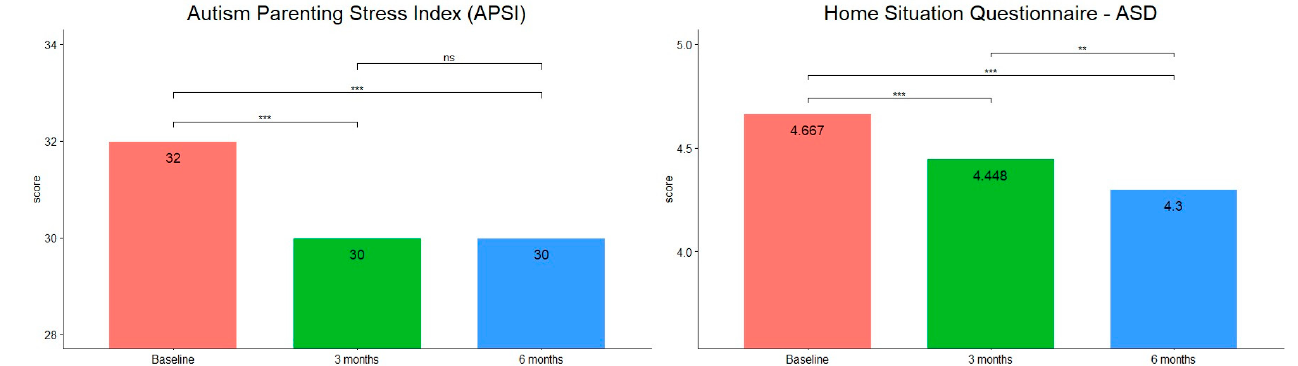
Figure 5. Median scores of HSQ-ASD and ASPI at the three timepoints (***: p -value < 0.001; **: p -value < 0.01; ns, not significant).